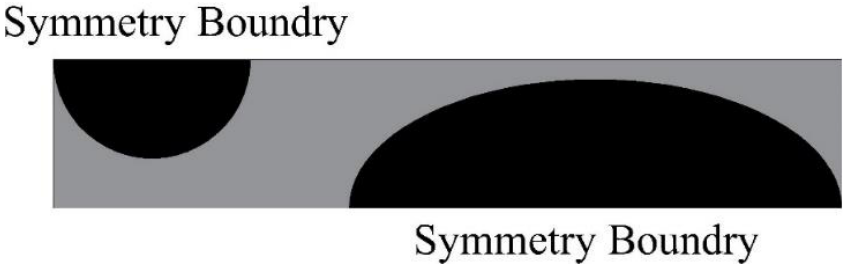
Figure 7. Heat exchanger unit boundary conditions.